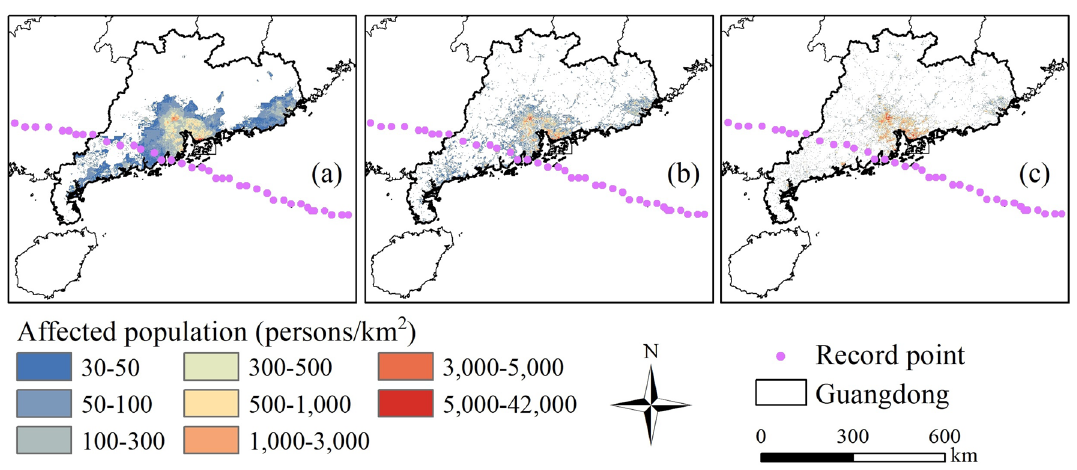
Fig. 10 Spatial distribution of population affected by typhoon Hato (1713) calculated from three population grid datasets. Plots a , b , and c are the affected population calculated by RESD, WorldPop, and GBCU,